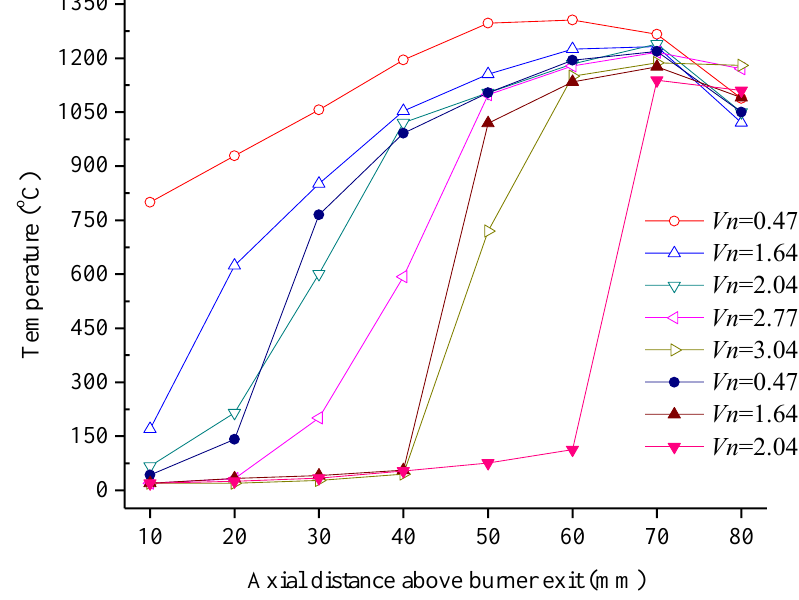
Figure 5. Axial distribution of flame centerline temperature for 21%O 2 –79%N 2 (open symbols) and 21%O 2 –79%CO 2 (solid symbols).